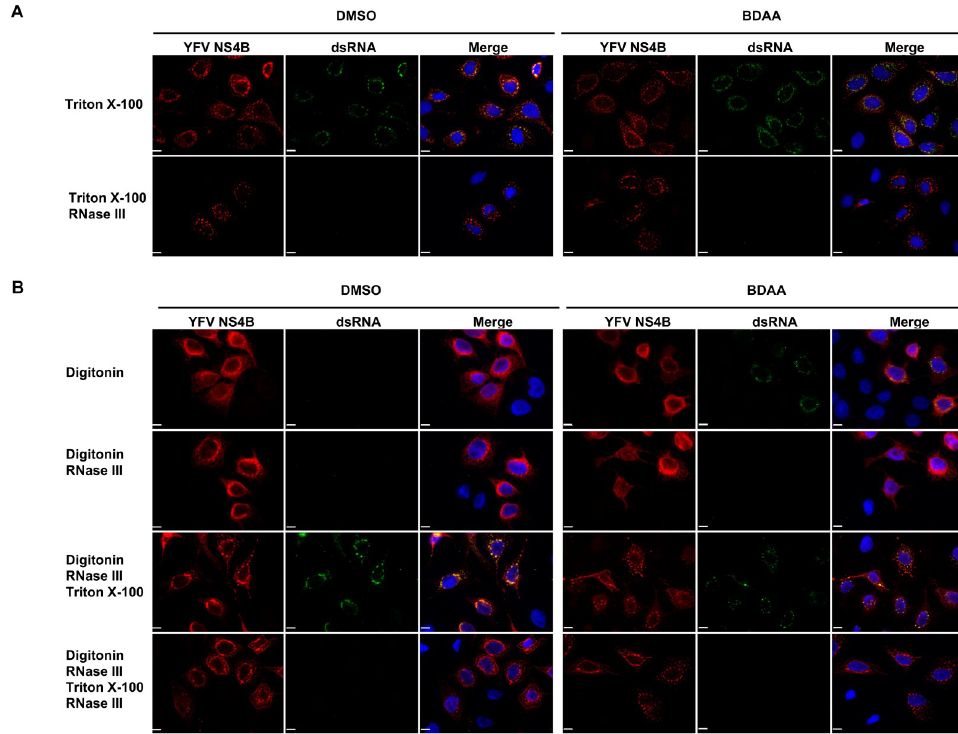
Fig 5. BDAA treatment induced exposure of dsRNA is sensitive to RNase III. Huh7 cells seeded on coverslips in 24 well plates were infected with YFV at MOI of 1 for 24 h followed by treatment with DMSO or 5 μ M BDAA for 6 h. (A) The cells were in situ permeabilized by Triton X-100 without or with RNase III treatment. (B) The cells were permeabilized by digitonin (top row). Alternatively, after in situ permeabilization with digitonin, cells were either additionally treated with RNase III (second row), RNase III treatment followed by permeabilization with Triton X-100 (third row), or RNase III treatment followed by permeabilization with Triton X-100 and another round of RNase III treatment (bottom row). Following the indicated treatment, the cells were fixed and followed by immunofluorescence staining using YFV NS4B or dsRNA antibodies. YFV NS4B (red), dsRNA (green) and cell nuclei (blue) were visualized. Scale bar is 100 μ